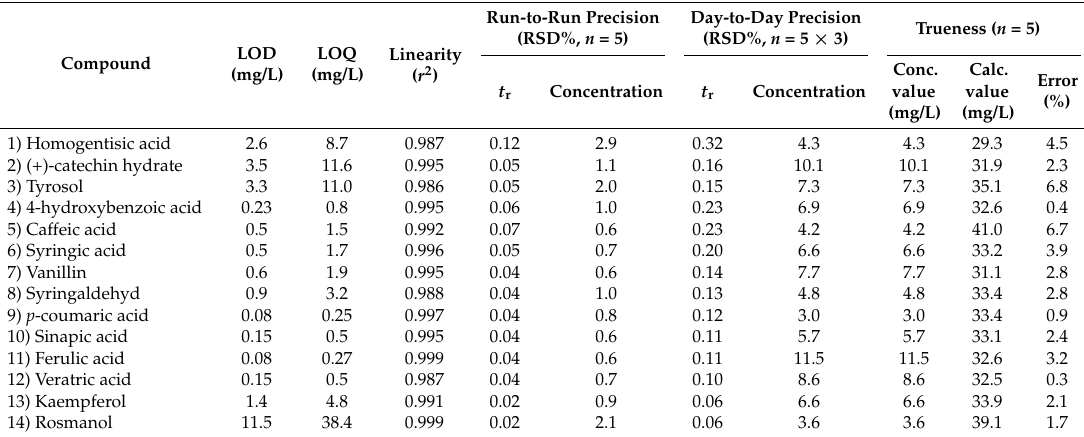
Table 2. HPLC-UV instrumental quality